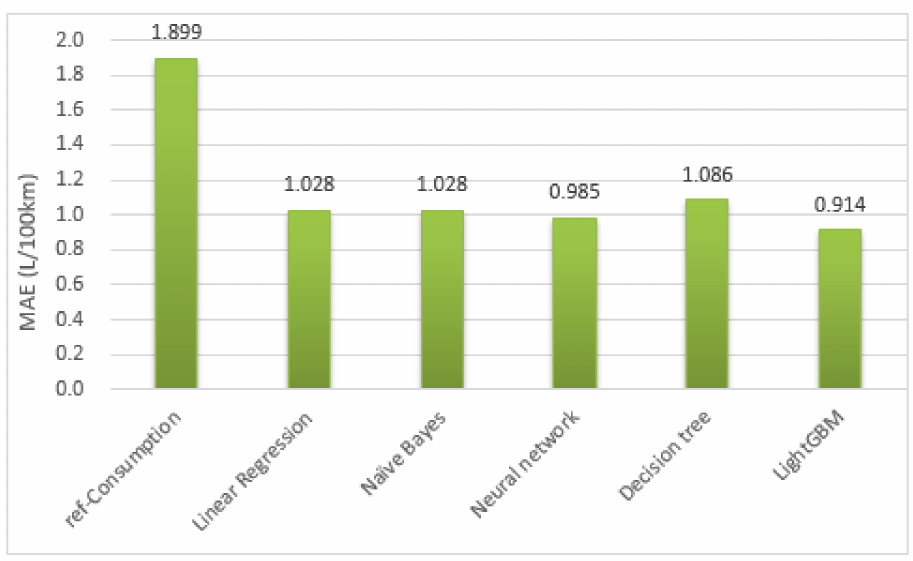
Figure 2. MAE of different